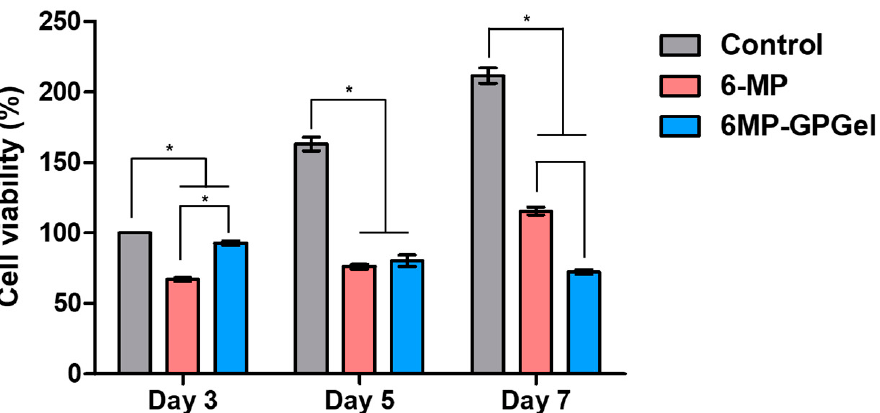
Figure 7. In vitro anticancer effects of 6MP-GPGel on colon cancer HCT-116 cells. (*) indicates that experimental groups are statistically different from each other.